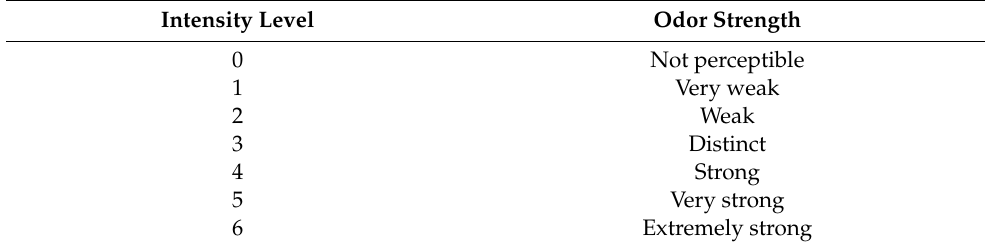
Table 2. German standard VDI 3940 odor intensity